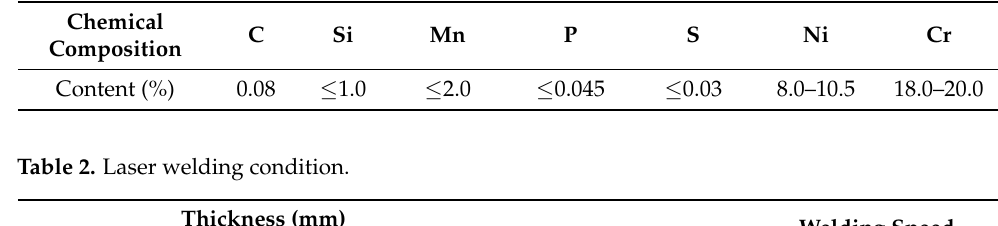
Table 1. Chemical composition of STS304.